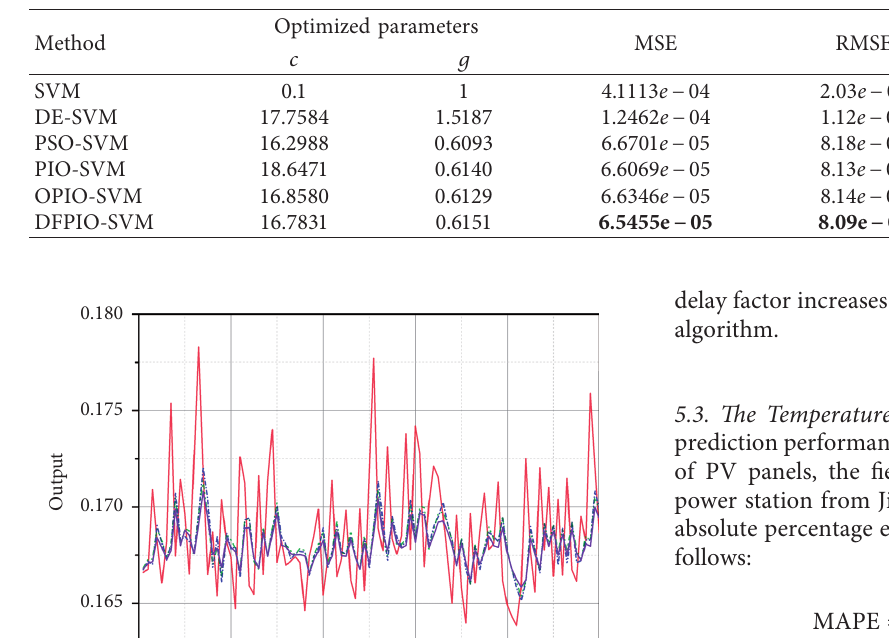
Figure 6: Iterative curves of three optimization Table 1: Comparison of prediction accuracy for the Mackey–Glass time series.